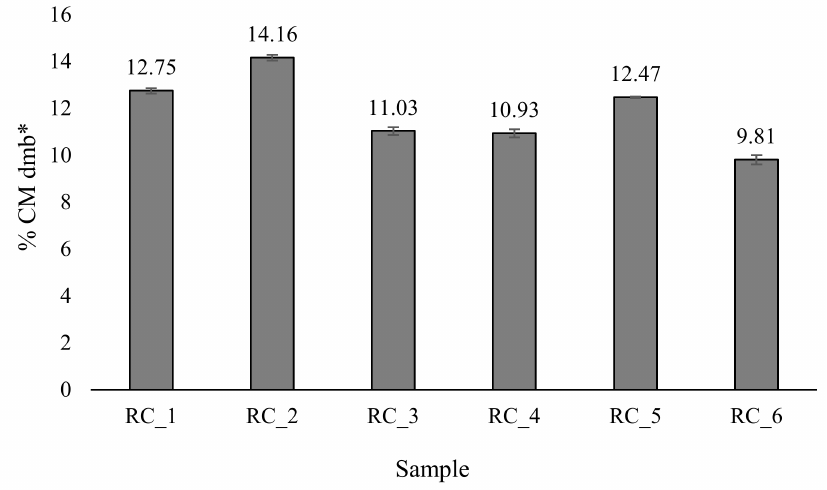
Figure 1. Melanoidin content in roasted (RC) coffee beans. CM—caramel melanoidins; * dmb—dry matter